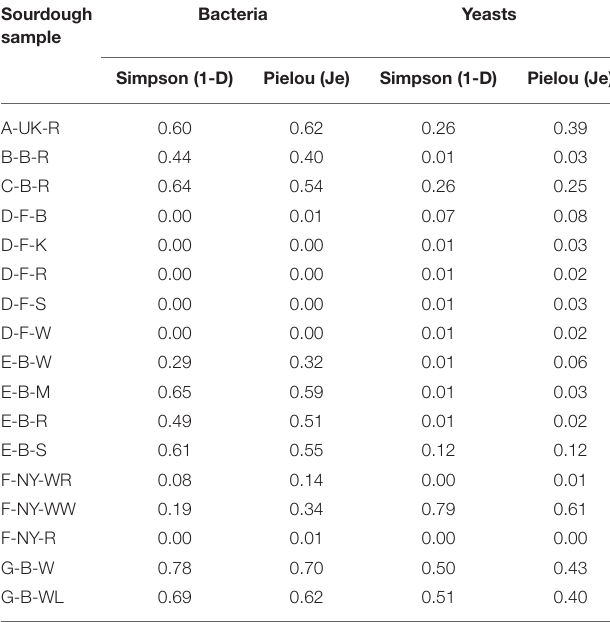
TABLE 2 | Intra-species diversity of 17 sourdough samples from backslopped sourdoughs of different origins, based on the relative abundances of bacterial and yeast species obtained by metagenetic